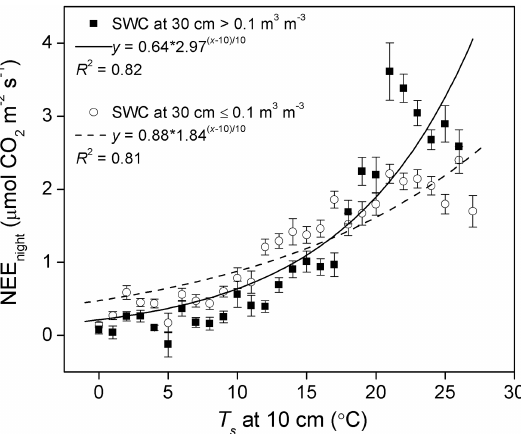
Figure 5. Nighttime net ecosystem CO 2 exchange (NEE night ) as a function of soil temperature ( T s ) at 10cm depth under different soil water contents (SWC) measured at 30cm depth. Only data when T s >0 ◦ C were used. Half-hourly NEE night was bin-averaged into 1 ◦ C T s intervals. Error bars indicate standard errors.